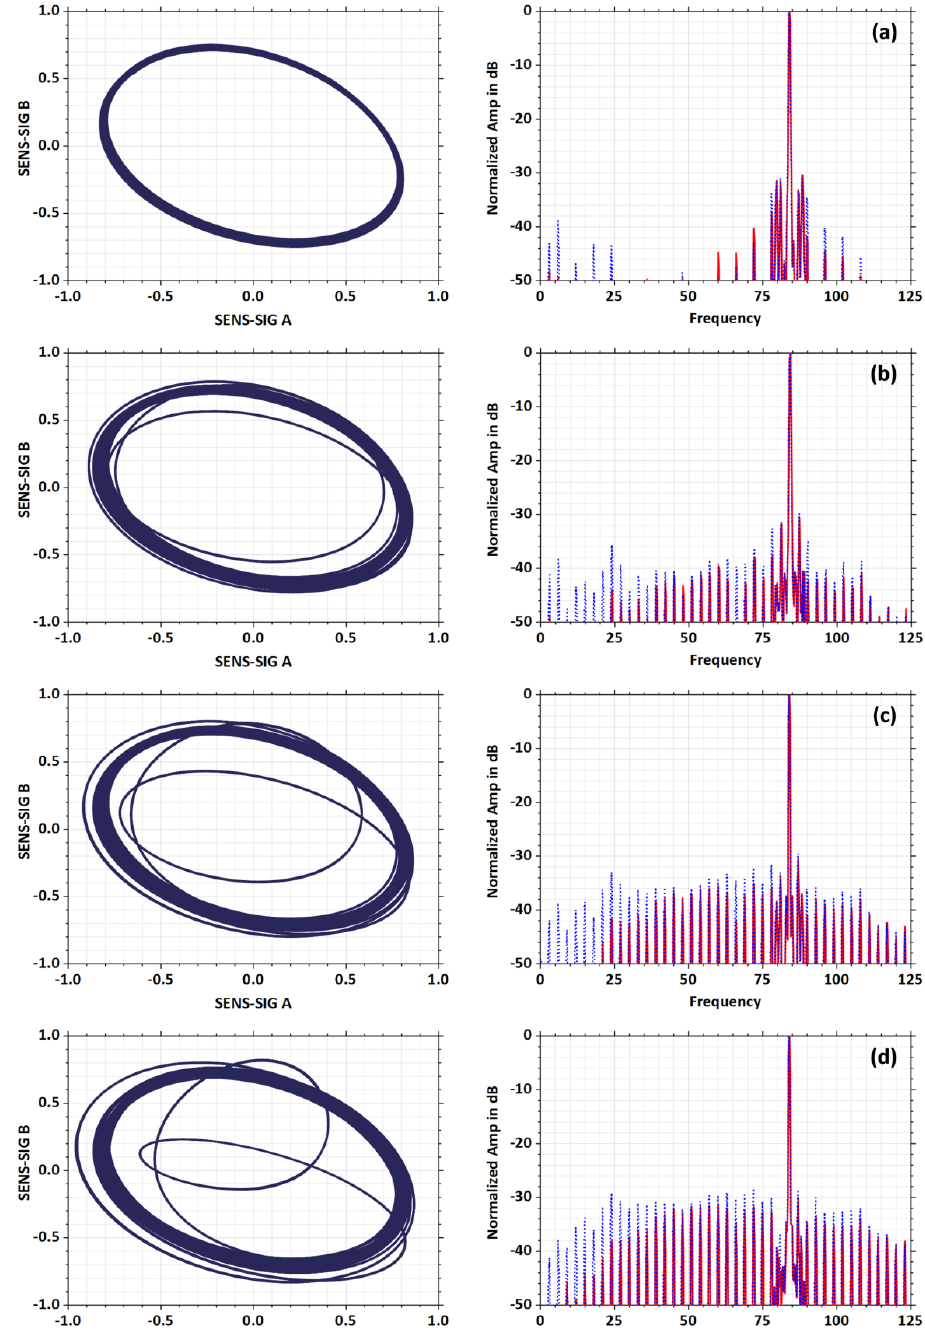
Figure 20. Comparison of FFT and oval patterns for the rate of rotor bar failure: ( a ) Reference oval pattern for rotor without defect; ( b ) 25% Cross-Section Loss; ( c ) 50% Cross-Section Loss; ( d ) 75% Cross-Section Loss.